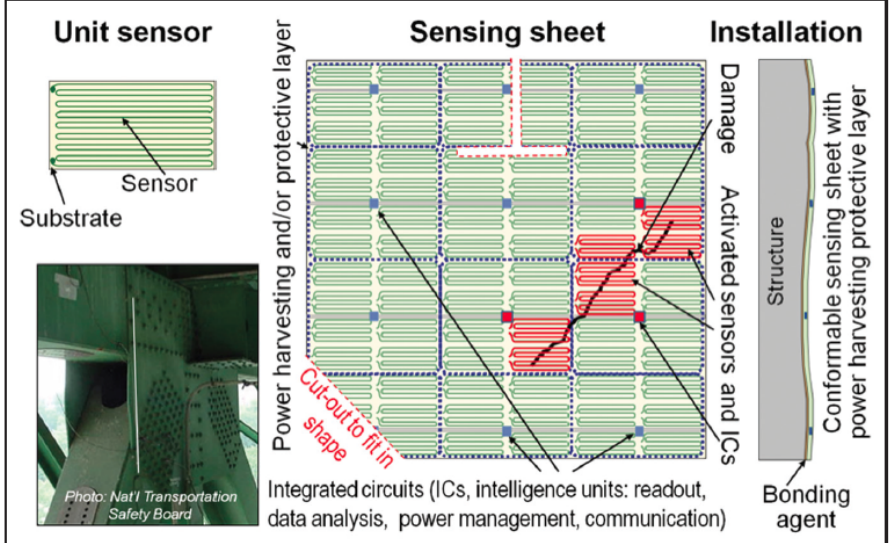
Figure 3. Schematic representation of the sensing sheet based on LAE and ICs